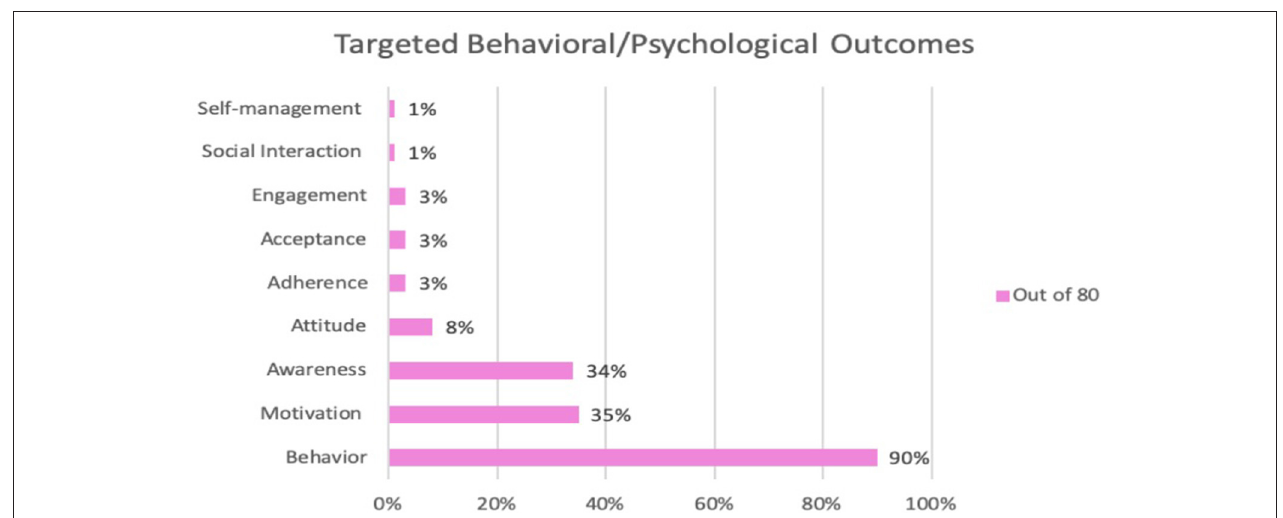
FIGURE 12 | Targeted psychological and behavioral outcomes by persuasive technology